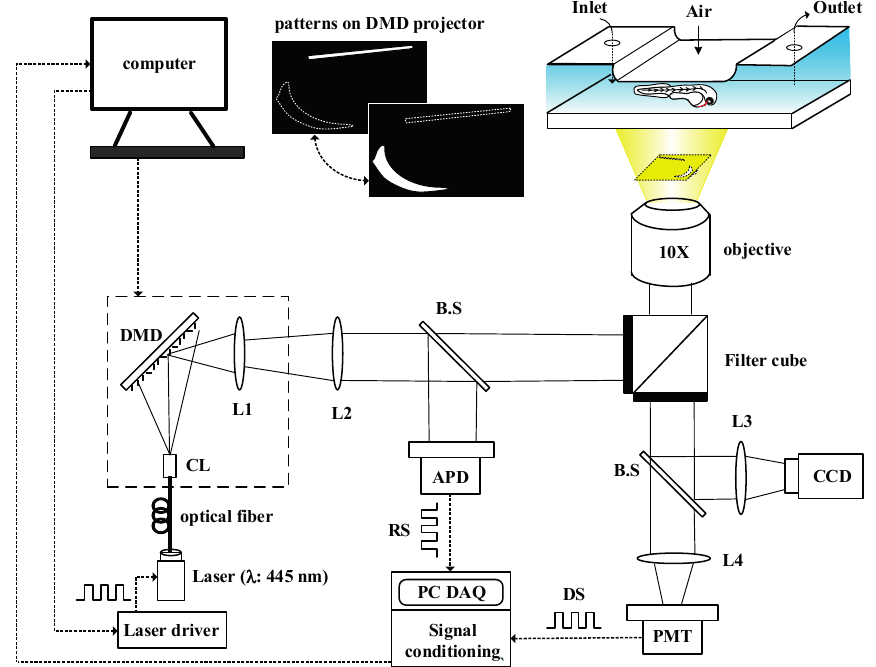
Figure 2. A schematic of the digital light modulation system utilizing a modified commercial DMD projector equipped with a fiber-guided laser diode as the light modulation source to spatially direct excited light toward a zebrafish embryo to detect in vivo tissue oxygenation in real time via phase-based phosphorescence lifetime